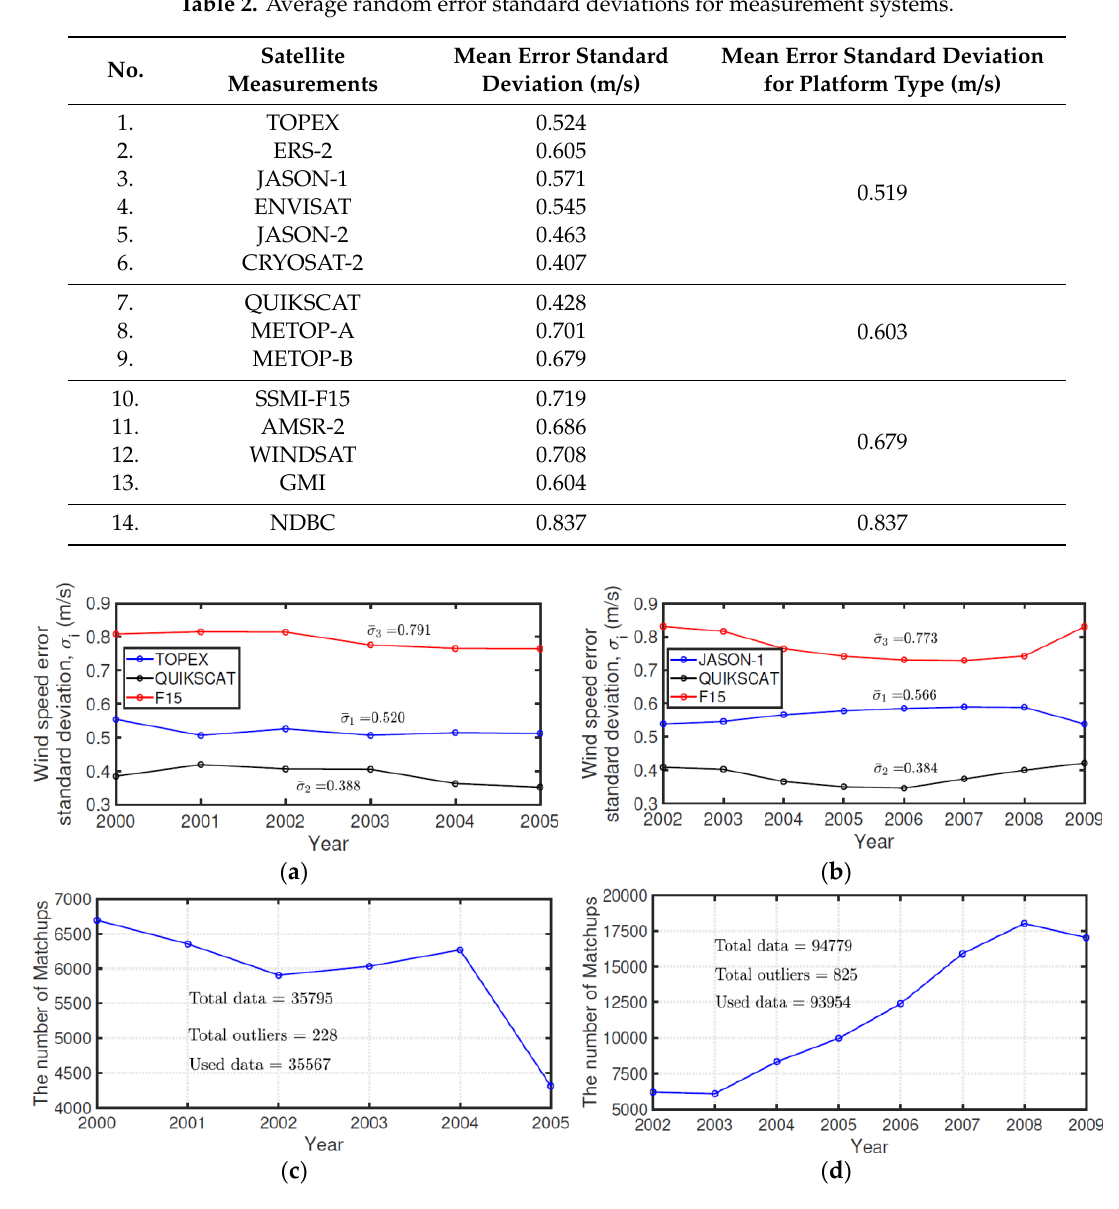
Figure 3. Error standard deviations, ( σ i ) , (m / s) per year for ( a ) TOPEX, QUIKSCAT, and SSMI-F15; ( b ) JASON-1, QUIKSCAT, and SSMI-F15; ( c ) The number of matchups used per year for the case ( a ); ( d ) The number of matchups used per year for the case ( b ). The results in ( a ) and ( b ) show that the error standard deviations are approximately constant over time, a requirement of the triple collocation approach.